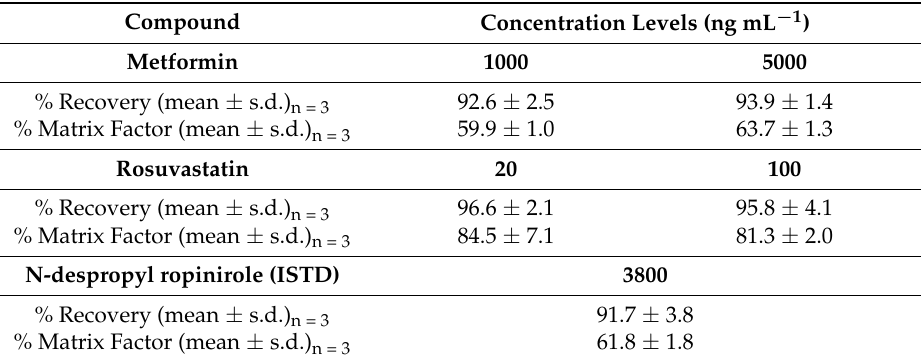
Table 3. Recovery and ion suppression data for the quantitation of metformin and rosuvastatin by